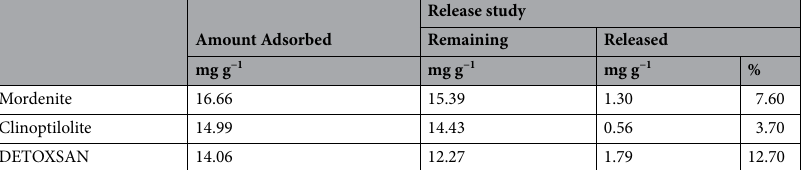
Table 5. 5-HT-hc uptake and release capacities of clinoptilolite, mordenite and DETOXSAN at a pH of 7. Amount of bound 5-HT-hc is the average value between 40 and 120 min after the addition of loaded zeolite samples into the incubation medium (see Fig.